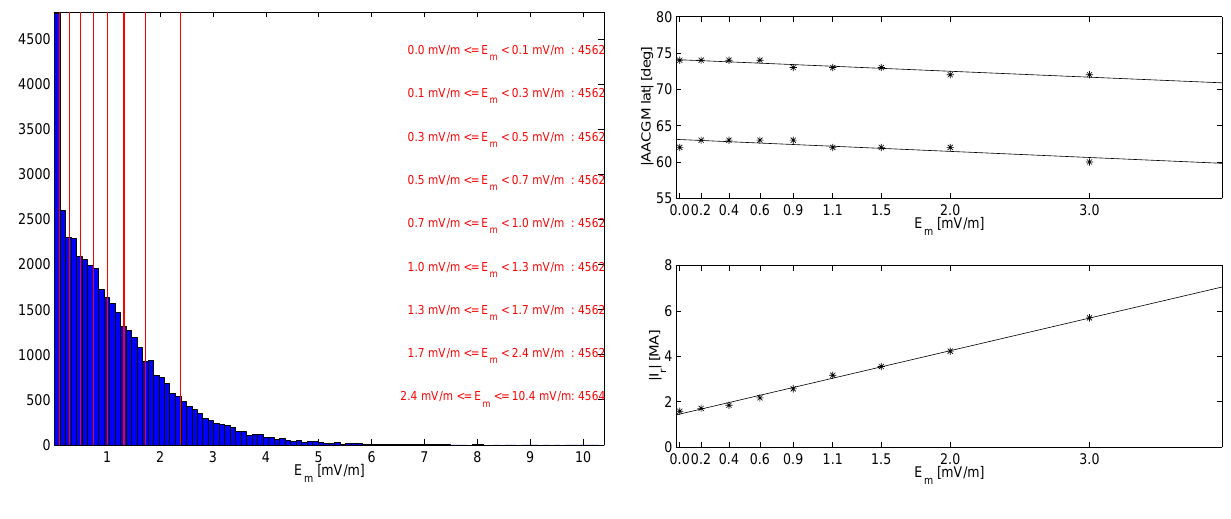
Fig. 10. Left: Distribution of the overflights as a function of the merging electric field ( E m ). The red lines display the bin boundaries and the number of overflights in each bin is written in red. Right: The equatorward and poleward boundaries of the auroral oval and the total field-aligned current as a function of E m